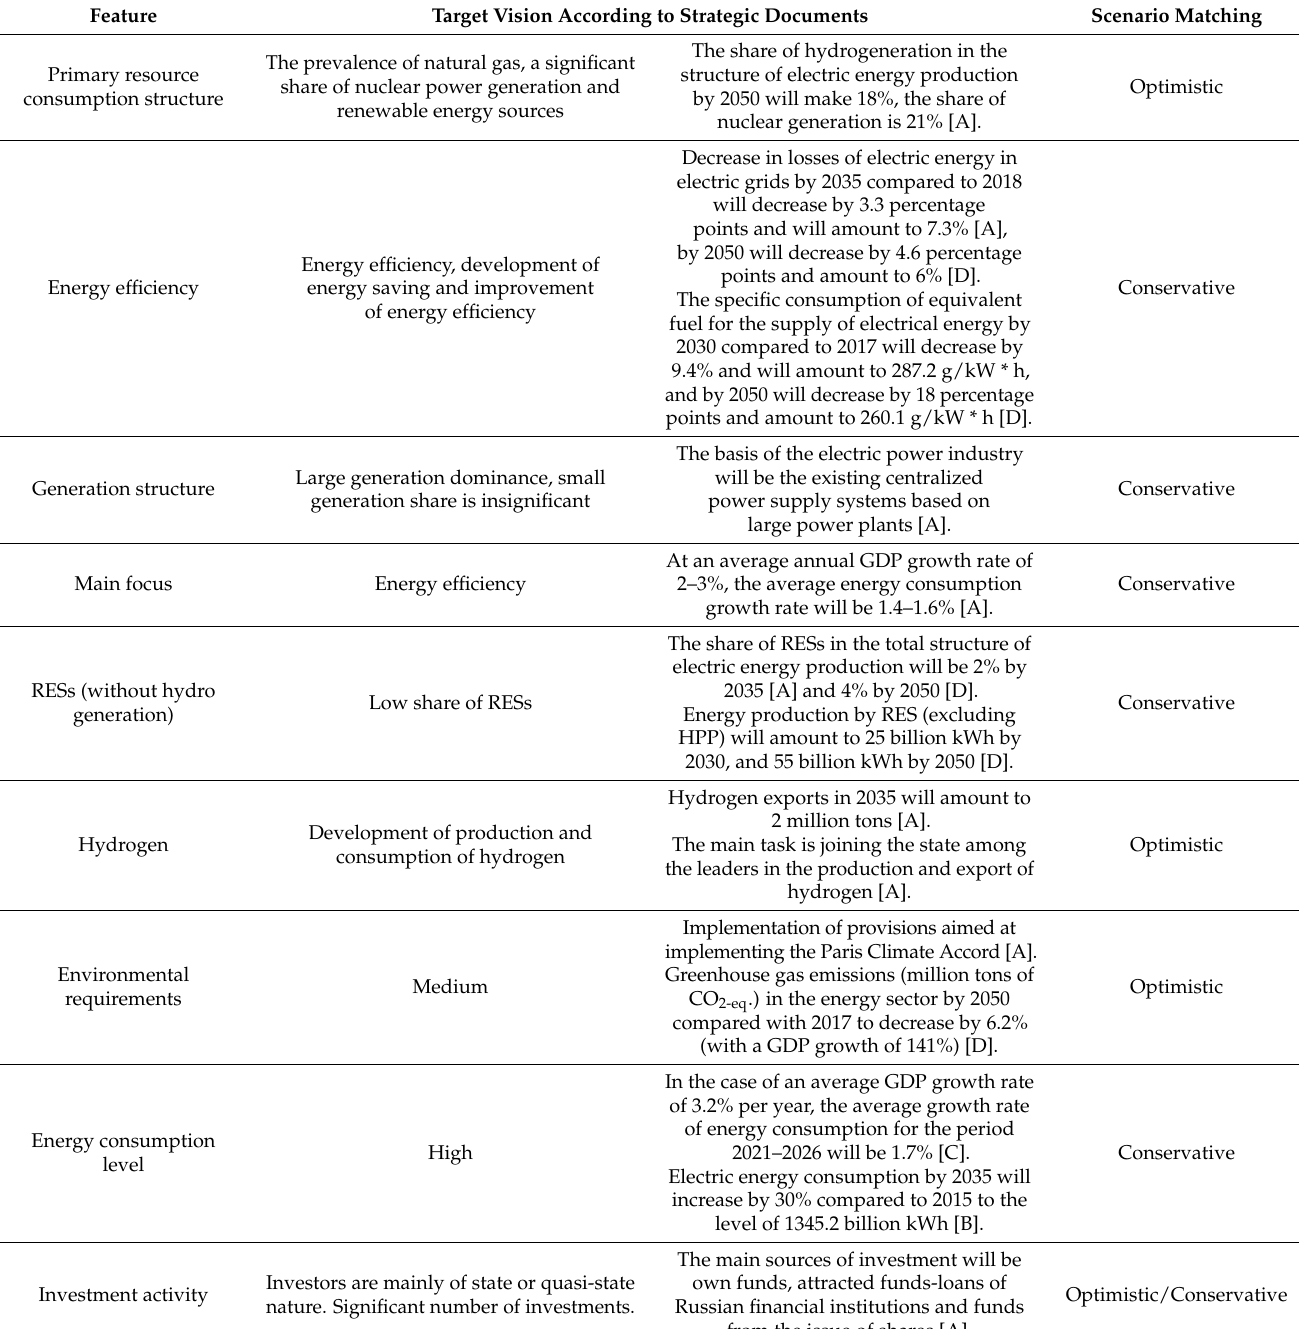
Table 6. The vision of energy progress scenarios in Russia’s strategic documents [A], [B], [C], and [D].